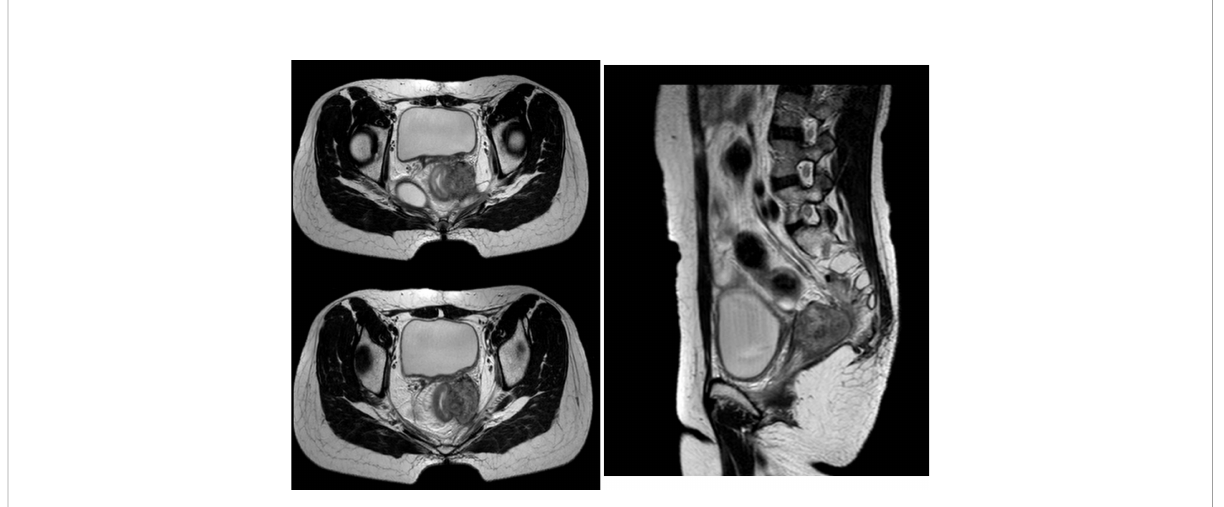
FIGURE 1 Pelvic MRI before reirradiation, recurrent tumors are shown in red